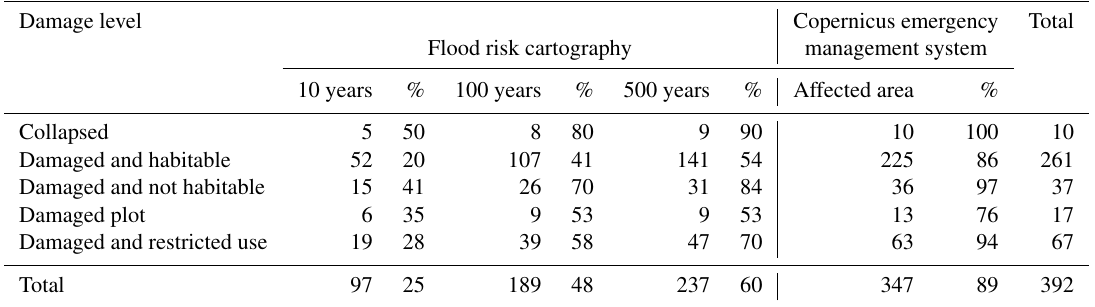
Table 3. Damaged buildings in the village of Sant Llorenç des Cardassar caused by the violent flash flood on 9 October 2018 and those encompassed in the official flood risk maps for 10-, 100- and 500-year recurrence